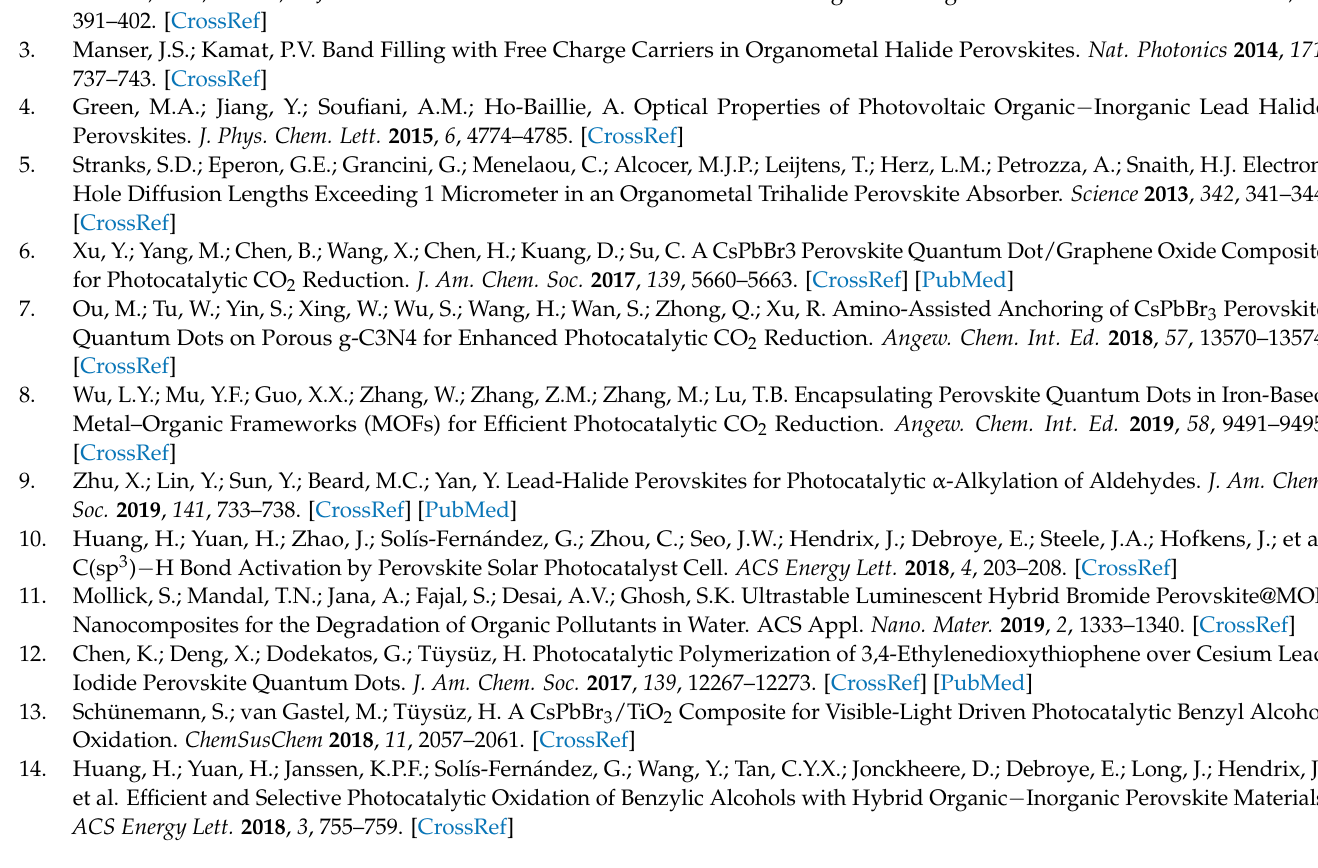
(I) 5/RS-IO-CsPbBr3. Figure S2: The SEM image of 2/AS-IO-CsPbBr3 fabricated by different pre- cursor concentration: 0.3M (A), 0.45M (B). Figure S3: The TEM image of (A) 3/AS-IO-CsPbBr3, (B) 4/AS-IO-CsPbBr3, (C) 5/AS-IO-CsPbBr3, and (A1), (A2), (B1), (B2), (C1), (C2) the SEAD images of the circle area in (A), (B), (C) respectively. Figure S4: The TEM image of (A) 2/RS-IO-CsPbBr3, (B) 3/RS- IO-CsPbBr3, (C) 4/RS-IO-CsPbBr3, (D)5/RS-IO-CsPbBr3, and (A1), (A2), (B1), (B2), (C1), (C2) (D1), (D2) the SEAD images of the circle area in (A), (B), (C), (D) respectively. Figure S5: Normalised ab- sorbance UV/Vis spectra of (A) AS-IO-CsPbBr3 and (B) RS-IO-CsPbBr3. Figure S6: Time-dependent UV-vis spectra of the photocatalytic reaction of (A) 3/AS-IO-CsPbBr3, (B) 4/AS-IO-CsPbBr3, (C) 5/AS-IO-CsPbBr3, and (D) 3/RS-IO-CsPbBr3, (E) 4/RS-IO-CsPbBr3, (F) 5/RS-IO-CsPbBr3. Fig- ure S7: (A) the IR spectrum of TerEDOT and the crystal/polymer composite (the peak at 3104 cm-1 is attributed to the C=C-H stretching vibration of TerEDOT, which could not be found in the crystal/polymer composite). Figure S8: The SEM image of the spent 2/AS-IO-CsPbBr 3 in low magnification. Figure S9: XRD patterns (A) and Normalised absorbance UV/Vis spectra (B) of the spent 2/AS-IO-CsPbBr 3